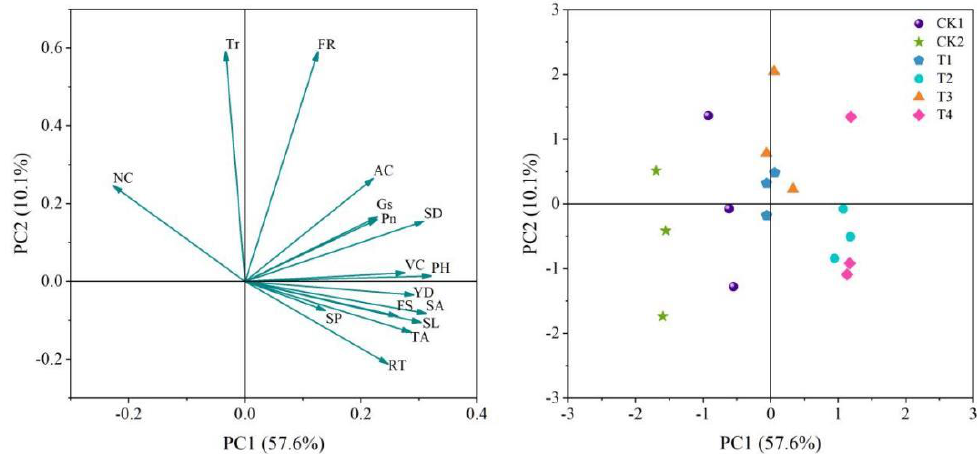
Figure 7. Principal component (PC) analysis of the relationships among root zone temperature, plant growth, and fruit quality yield. The direction and length of arrows indicate the correlations and their strengths, respectively. Bars represent standard errors. RT, root temperature; PH, plant height; SD, stem diameter; SL, leaf; SP, SPAD; SA, leaf area; PN, photosynthetic rate; AC, organic acid; TA, total soluble sugar; NC, nitrate content; VC, vitamin C; FS, fresh shoot weight; FR, fresh root weight; YD, yield.